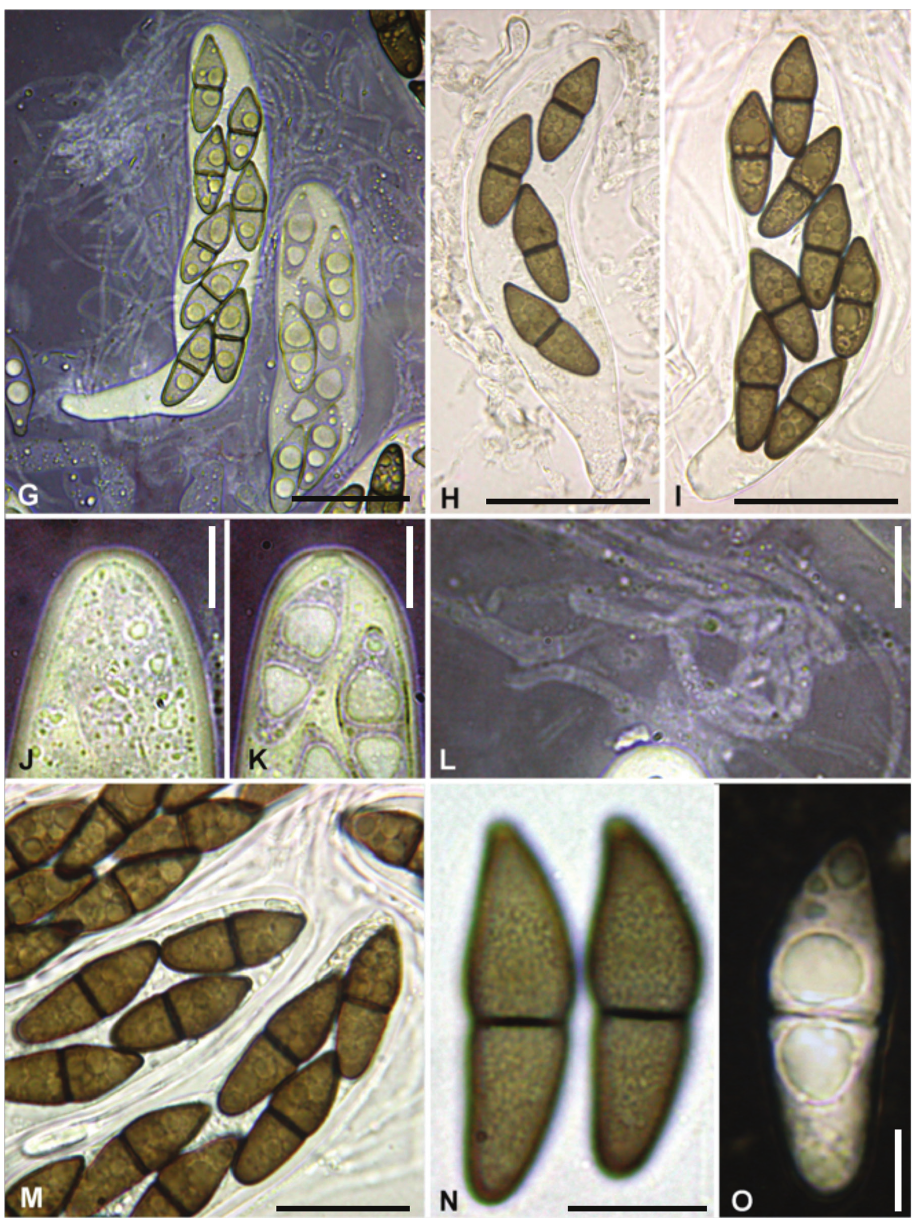
Figure 2. G–I Clavate to obclavate asci. J, K Ascus apex showing faint truncate ocular chamber L Pseu- doparaphyses M–N Multiguttulate brown ascospores. Note ascospores showing minutely verrucose warts forming a loose reticulate pattern O Immature ascospore in India ink. Scale bars: G–I, M = 20 µm; J–L = 5 µm; N, O = 10